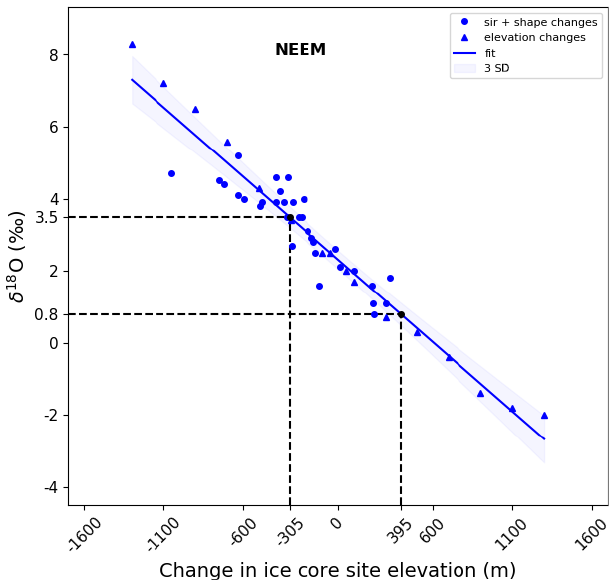
Figure 8. δ 18 O p anomalies as a function of the NEEM ice core site elevation change (m) relative to PI. Solid lines signify best fit curves ( y = a + bx ) and shade envelopes represent ± 3 SD on the best fit lines. Triangles represent results for the 16 elevation change experiments. Dots represent results for the 32 simulations that ex- amine the joined impact of Arctic sea ice retreat (sir) and modified GIS